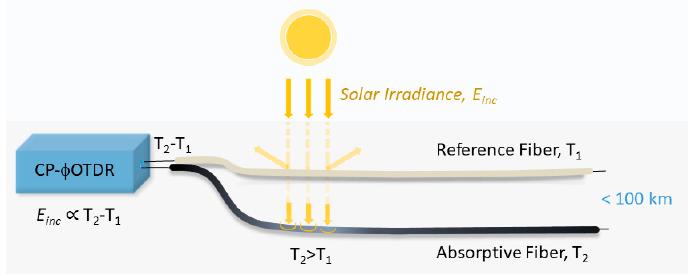
Figure 1. Representation of the operation of the proposed long-range distributed solar irradiance sensor.